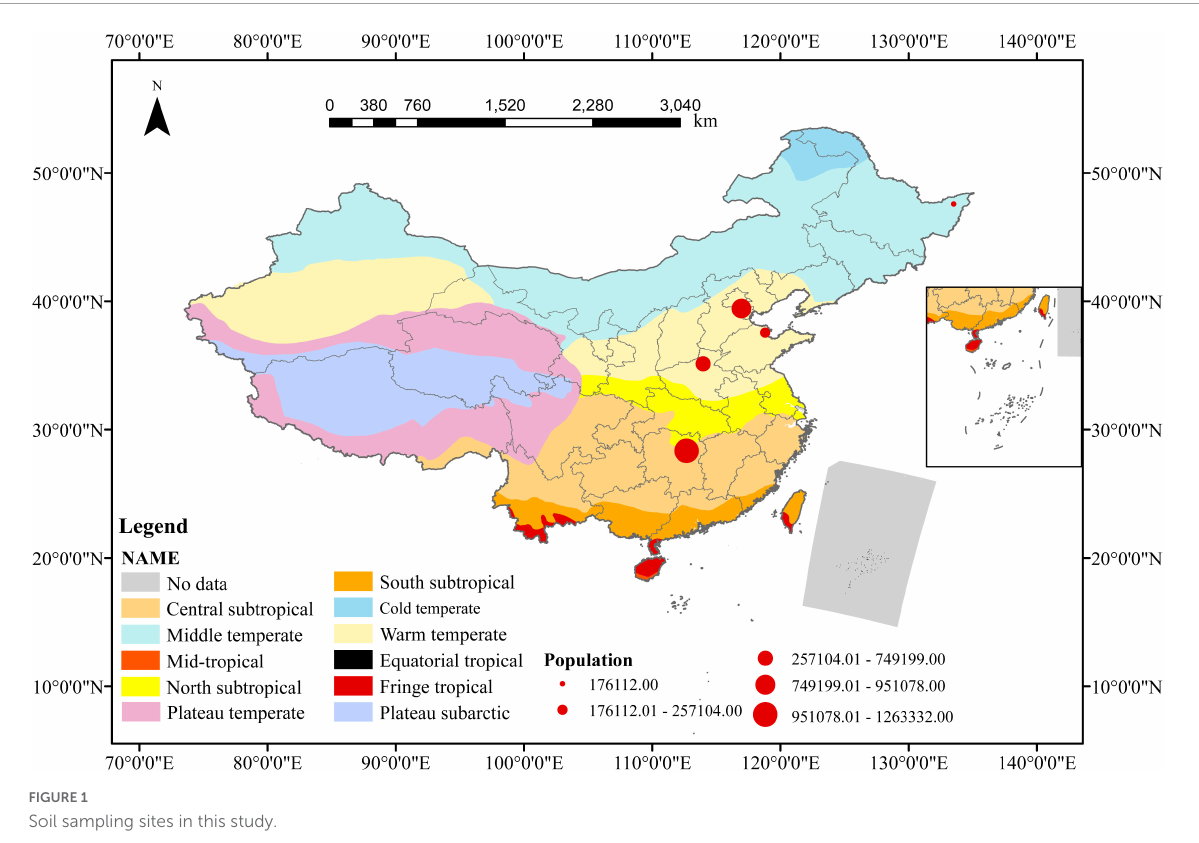
FIGURE1 Soil sampling sites in this